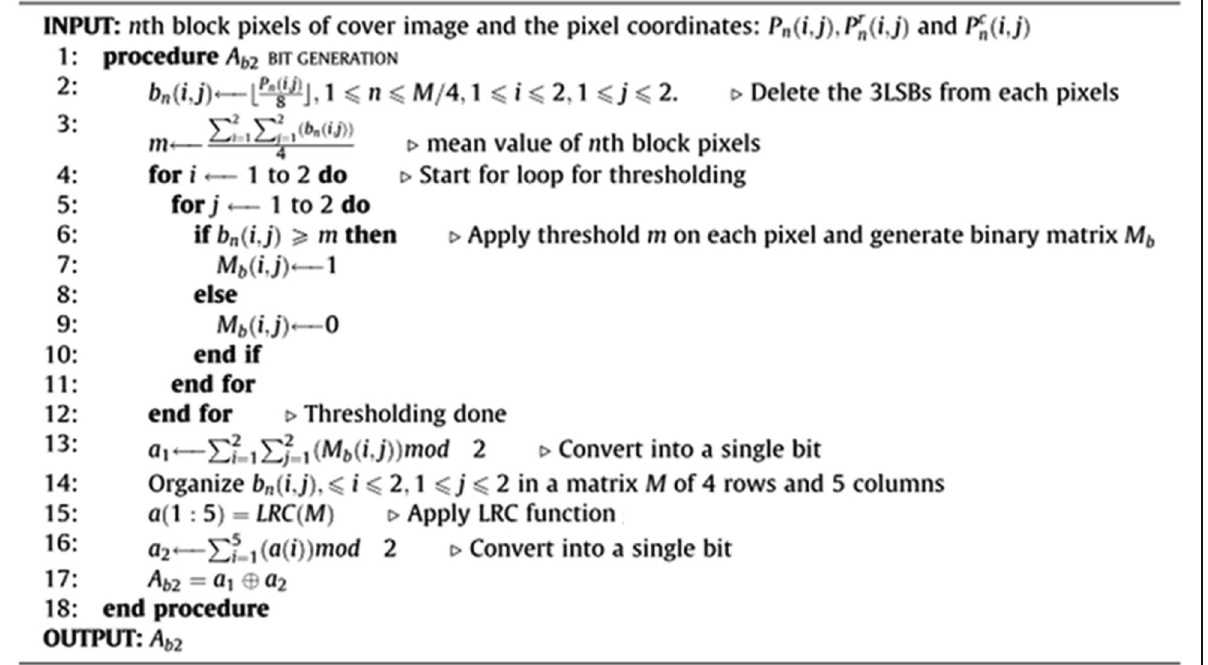
Fig. 7 Second authentication bit generation of Singh ’ s scheme